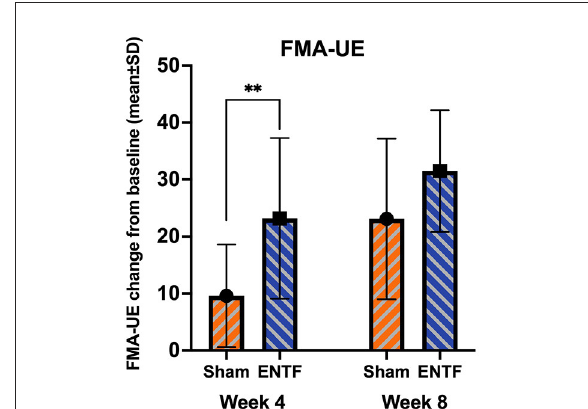
FIGURE2 Fugl-Meyer Assessment – Upper Extremity (FMA-UE) score changes from baseline to week 4 and week 8 (range: 0-66; 66 is greatest mobility/optimal recovery). FMA-UE absolute score change from baseline to week 4 (sample mean, error bars correspond to SD; significance based on difference in LSmeans) was significantly greater for the ENTF group than sham group (23.2 ± 14.1 vs. 9.6 ± 9.0; p = 0.007; ** < 0.01). Absolute score change from baseline to week 8 was also greater, though not significantly so, for the ENTF group than sham group (31.5 ± 10.7 vs. 23.1 ± 14.1; p = 0.06).